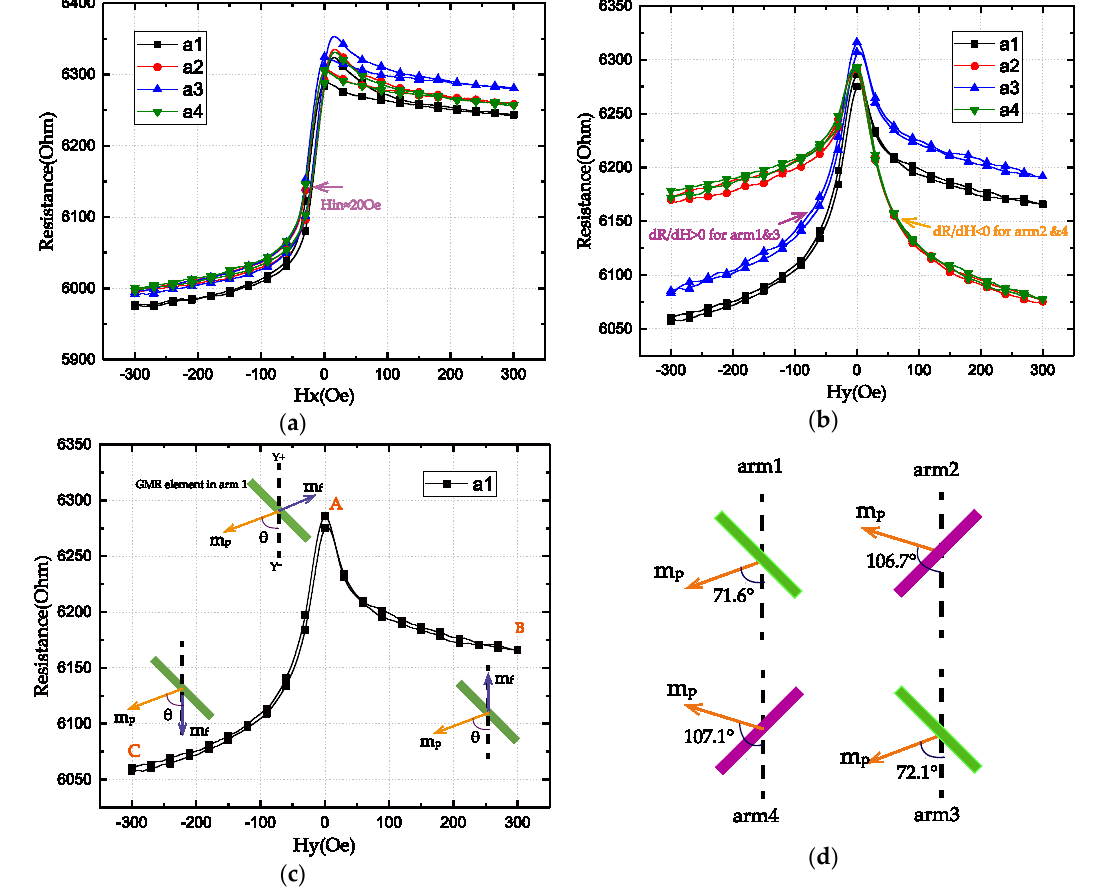
Figure 3. ( a , b ) R-H loops of the four bridge arms with the applied magnetic field along the x - and y -axes. ( c ) R-H loop of arm1 with the applied field along the y -axis. m f and m p denote the magnetization of the free and pinned layers. ( d ) Calculated deflection angles of pinned layer magnetization in GMR elements.